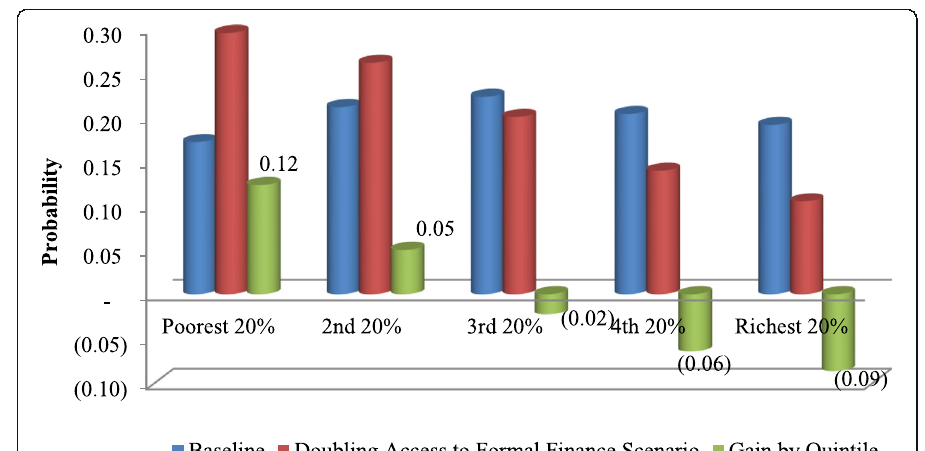
Fig. 1 Distributive benefit by income quintile when access to finance to individual farmers from conventional financial institutions is accelerated